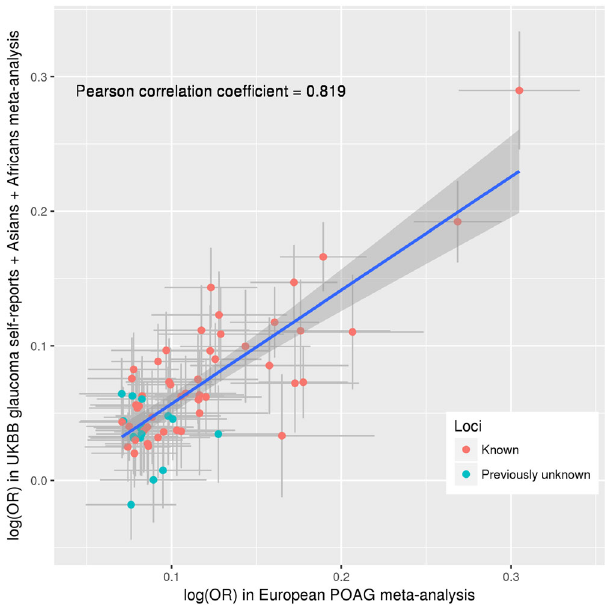
Fig. 2 Correlation of SNP effect estimates between the European POAG meta-analysis and the replication dataset. The x -axis shows effect estimates in log(OR) scale for the independent genome-wide signi fi cant loci obtained from the meta-analysis of POAG in Europeans (16,677 POAG cases vs. 199,580 controls). The y -axis shows the effect estimates in log(OR) scale for the same SNPs obtained from meta-analysis of the following three GWAS data: glaucoma self-reports in UKBB, POAG in Asians, and POAG in Africans (the overall sample size of 17,502 cases and 149,741 controls). Red dots are the previously identi fi ed risk loci and blue dots are the previously unreported risk loci identi fi ed in this study. Horizontal gray bars on each dot represent the 95% con fi dence intervals (CIs; mean values + / − 1.96*SEM) for the effect estimates in Europeans (from the GWAS meta-analysis of 16,677 POAG cases vs. 199,580 controls), and vertical gray bars shows the 95% CIs in the replication dataset (from the GWAS meta-analysis of 17,502 POAG cases vs. 149,741 controls). The blue line is the linear regression line best fi tting the data. The shaded area shows the 95% CIs on the repression